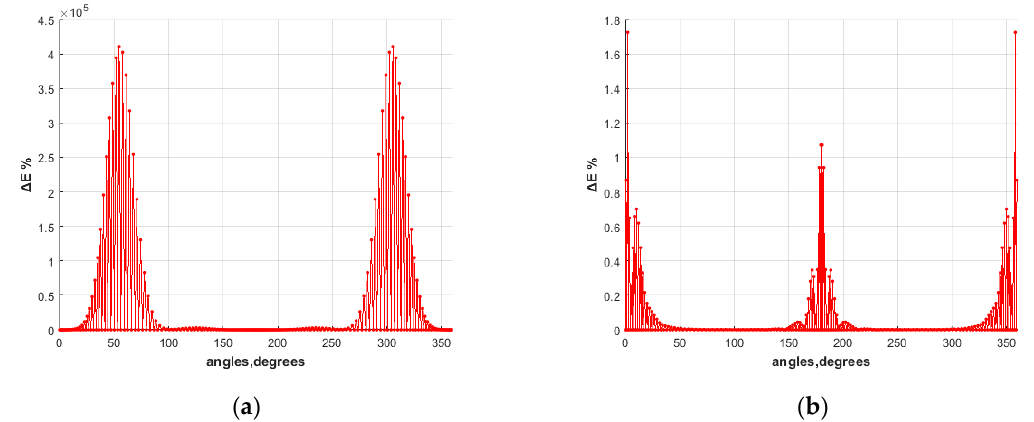
= (cid:2025) − 0.15(cid:2019) (cid:1853)(cid:1873)(cid:1876)